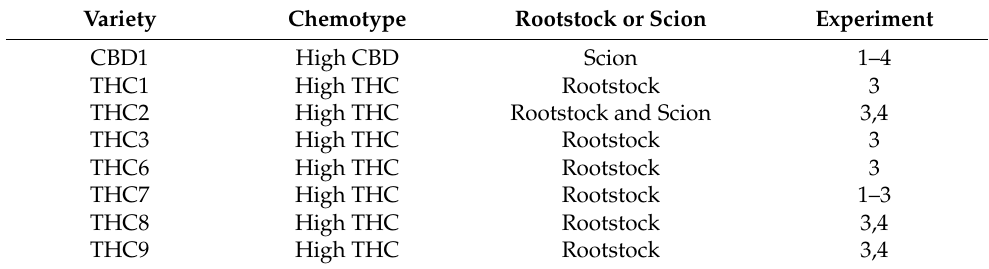
Table 1. Description of germplasm